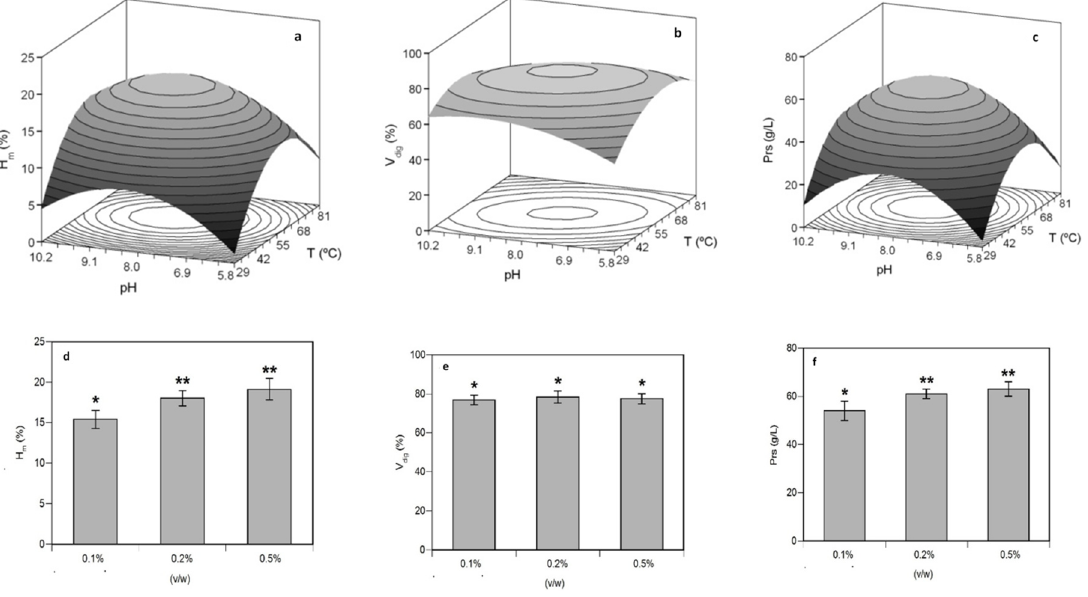
Figure 1. Optimization studies of Sb_He ( a – f ) and Sbass_He ( g – l ) hydrolysis by endogenous Alcalase. Theoretical response surfaces describe the joint effect of pH and T on H m ( a , d , g , l ), V dig ( b , e , h , k ) and Prs ( c , f , i , l ) variables. Histograms show the individual effect of Alcalase concentration on the same variables. Error bars are the intervals of confidence for n = 2 (replicates of different hydrolysates) and α = 0.05. Different asterisks in each histogram-graph means statistically significant differences ( p < 0.05).